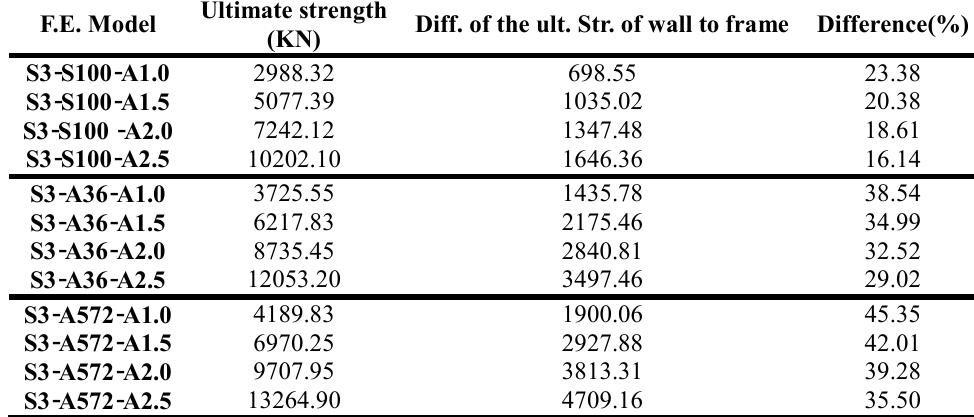
Fig. 10. The ultimate shear capacity of the finite element models. The ultimate shear capacity of the finite element